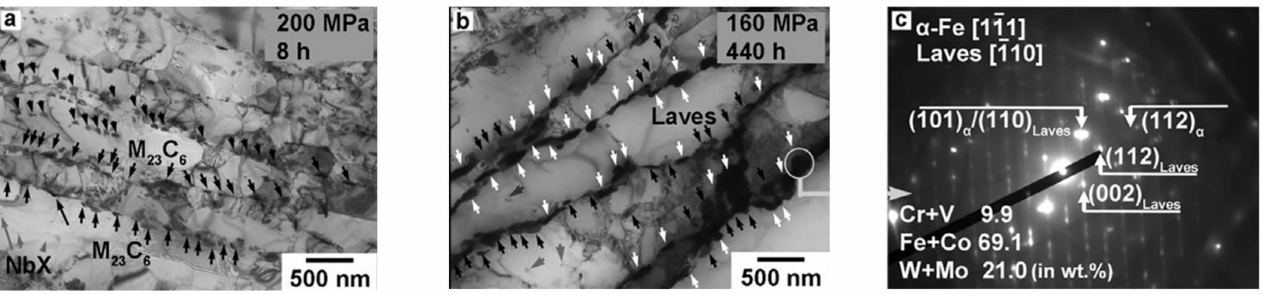
Figure 17. TEM micrographs of the 10Cr-0.2Re steel after short-term creep tests at 650 ◦ C: 200 MPa, 8 h ( a ) and 160 MPa, 440 h ( b ); black and white arrows indicate M 23 C 6 and Laves phase particles, respectively, located along the lath boundaries; grey arrows indicate NbX particles precipitated within the laths. Electron diffraction pattern ( c ) is obtained from the Laves phase particle shown by circle in ( b ). Reprinted with permission from Ref. [74], Copyright Elsevier 2018.